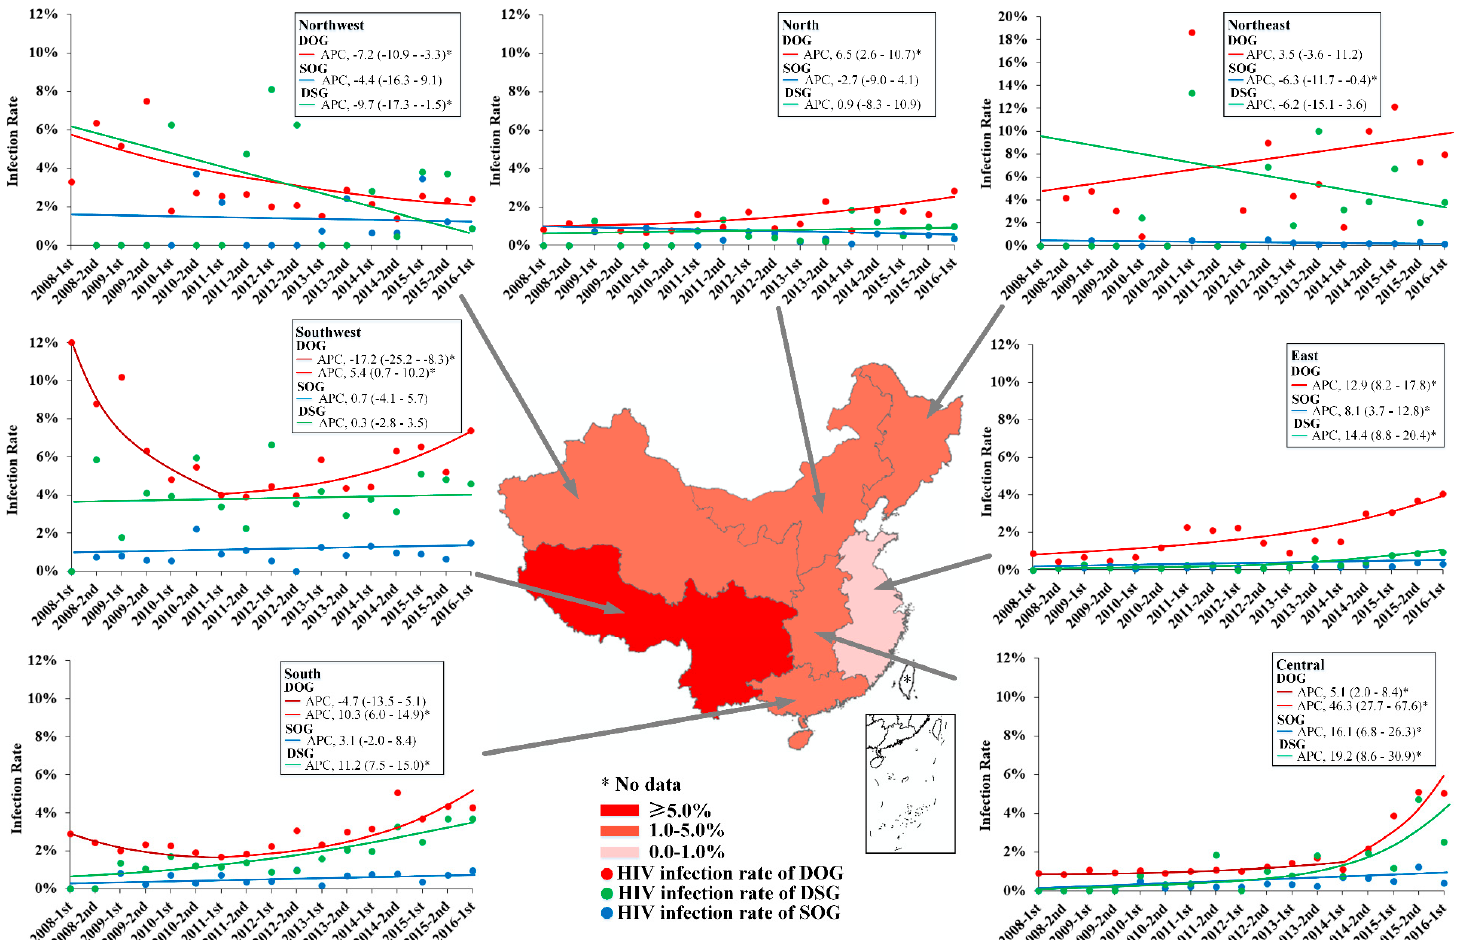
Figure 3. Trends of HIV infection rate among depressants only, stimulants only and both depressants and stimulants users stratified by regions. DOG: depressants only users. SOG: stimulants only users. DSG: both depressants and stimulants users. 1st: the first half year from January to June. 2nd: the second half year from July to December. * suggested p < 0.05 .